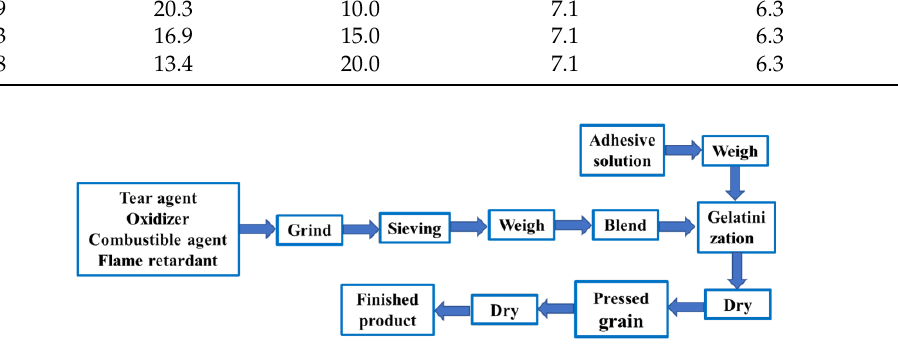
Figure 1. Sample preparation process.